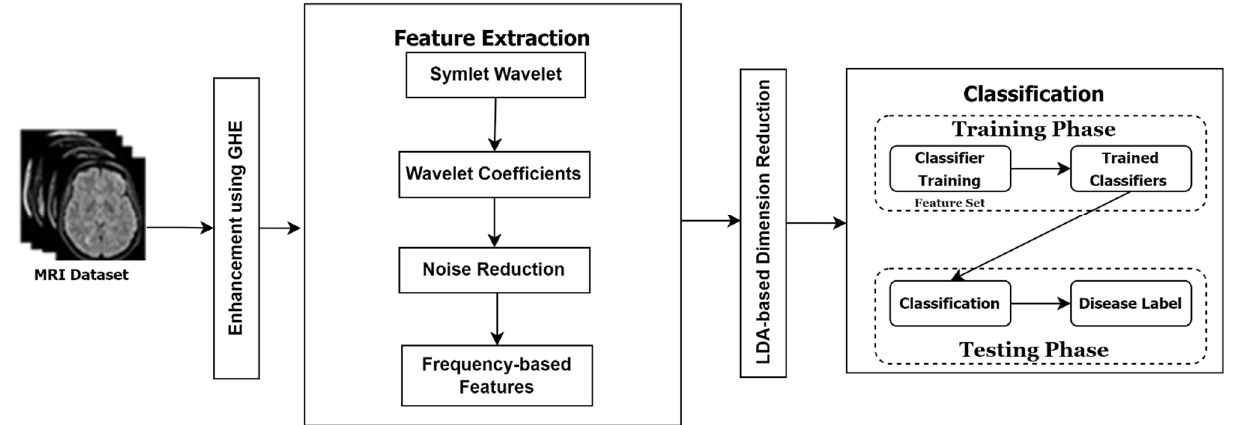
Figure 1. The working diagram of the proposed MRI classification Approach.